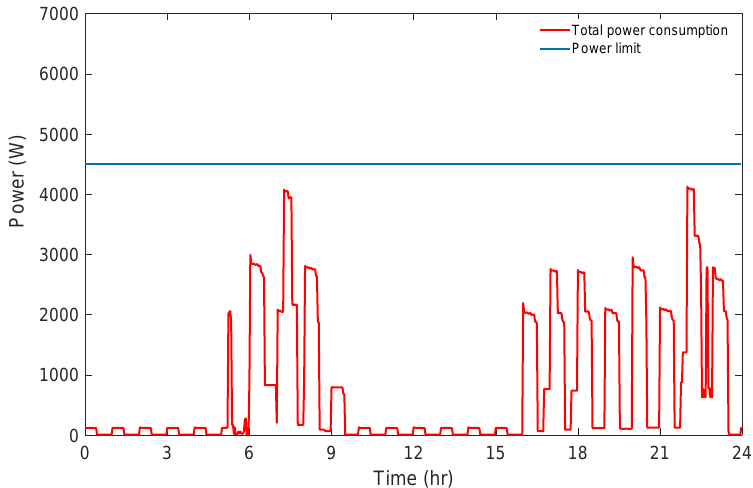
Figure 9. Power consumption graph of the optimal solution for Scenario